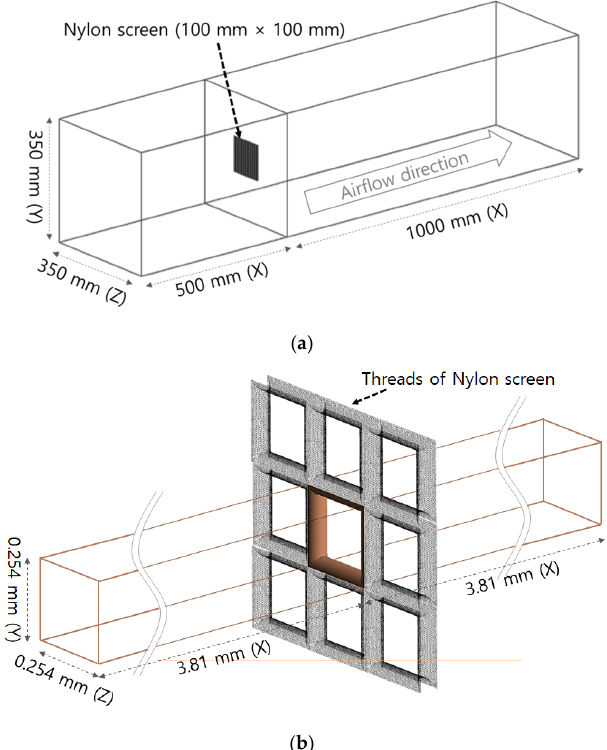
Figure 2. Computational grids for two-stage modelling: ( a ) first-stage grid; ( b ) second-stage grid.